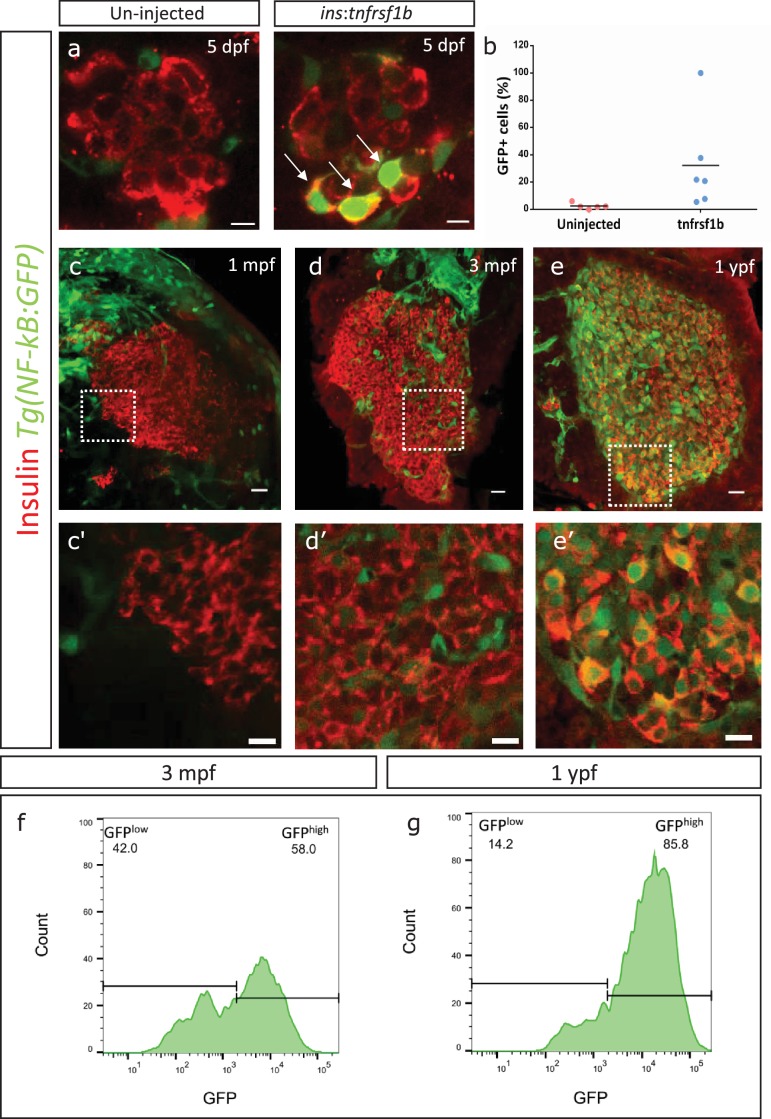
An inflammation reporter reveals heterogeneous activation of NF-kB signaling in beta-cells with age.(a) The images show single confocal planes from islets of 5 dpf larvae. The tnfrsf1b coding sequence was expressed under the control of the insulin promoter. The plasmid was injected in Tg(NF-kB:GFP) embryos at the one-cell-stage, leading to mosaic and stochastic expression of the construct in beta-cells. The Tg(NF-kB:GFP) reporter expresses GFP (green) under the control of six tandem repeats of NF-kB DNA-binding sites. Beta-cells were labelled using an insulin antibody (red). Arrows indicate GFP-positive beta-cells. Scale bar 5 µm. (b) The graph shows the percentage of GFP-positive and insulin-positive cells in uninjected controls (n = 5) and tnfrsf1b injected animals (n = 6) at 5 dpf. Horizontal bars represent mean values. (c–e) Confocal stack of islets from Tg(NF-kB:GFP) animals at 1 mpf, 3 mpf and 1 ypf. Beta-cells were labeled using an insulin antibody (red). NF-kB:GFP reporter expression is shown in green. Scale bars 20 µm. (c’–e’) Insets show high magnification single planes of the confocal stacks (corresponding to the regions shown using white dotted-lines in the top panels). Scale bar 10 µm. (f–g) Beta-cells from 3 mpf Tg(NF-kB:GFP) animals were labeled with TSQ (Zn2+ labeling dye) and analyzed using FACS. The graph shows GFP intensity (along the X-axis) and the distribution of beta-cells at 3 mpf and 1 ypf. Horizontal lines indicate the division point between GFPlow and GFPhigh levels. Percentage values represent proportion of cells with GFPlow or GFPhigh expression.